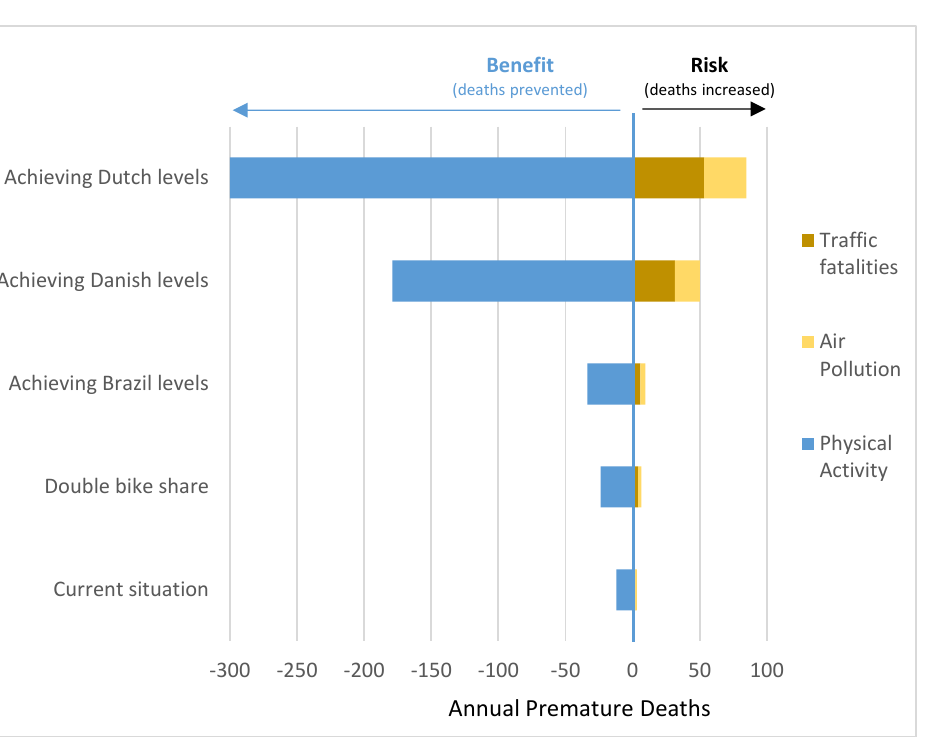
Table 2. Results of current and hypothetical bicycling scenarios in Mexico.